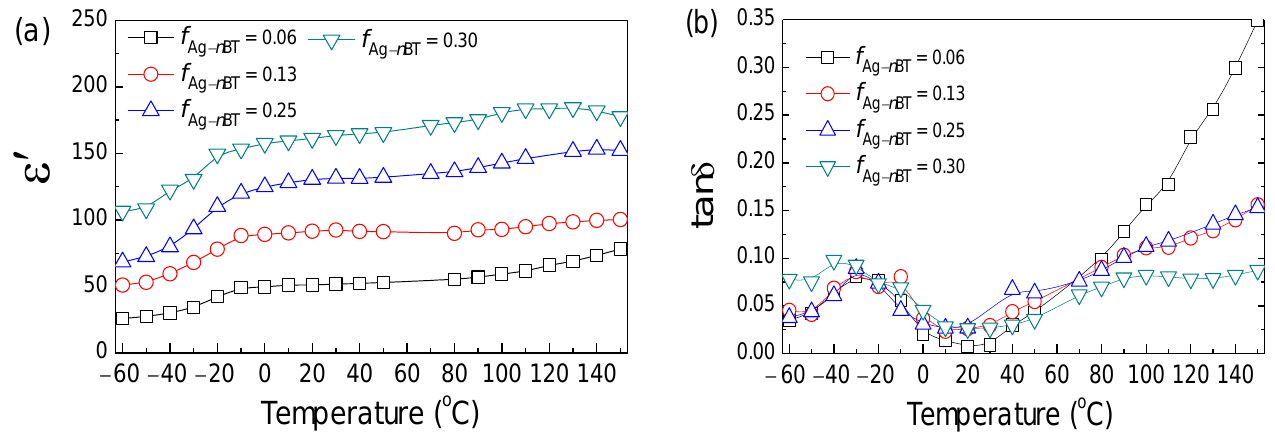
Figure 8. Temperature dependence on dielectric properties ( a ) ε′ and ( b ) tanδ of the Ag- n BT/PVDF-(0.2) μ BT composites with different f Ag-nBT.